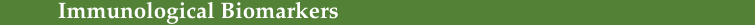
Table 1. Cont. Immunological